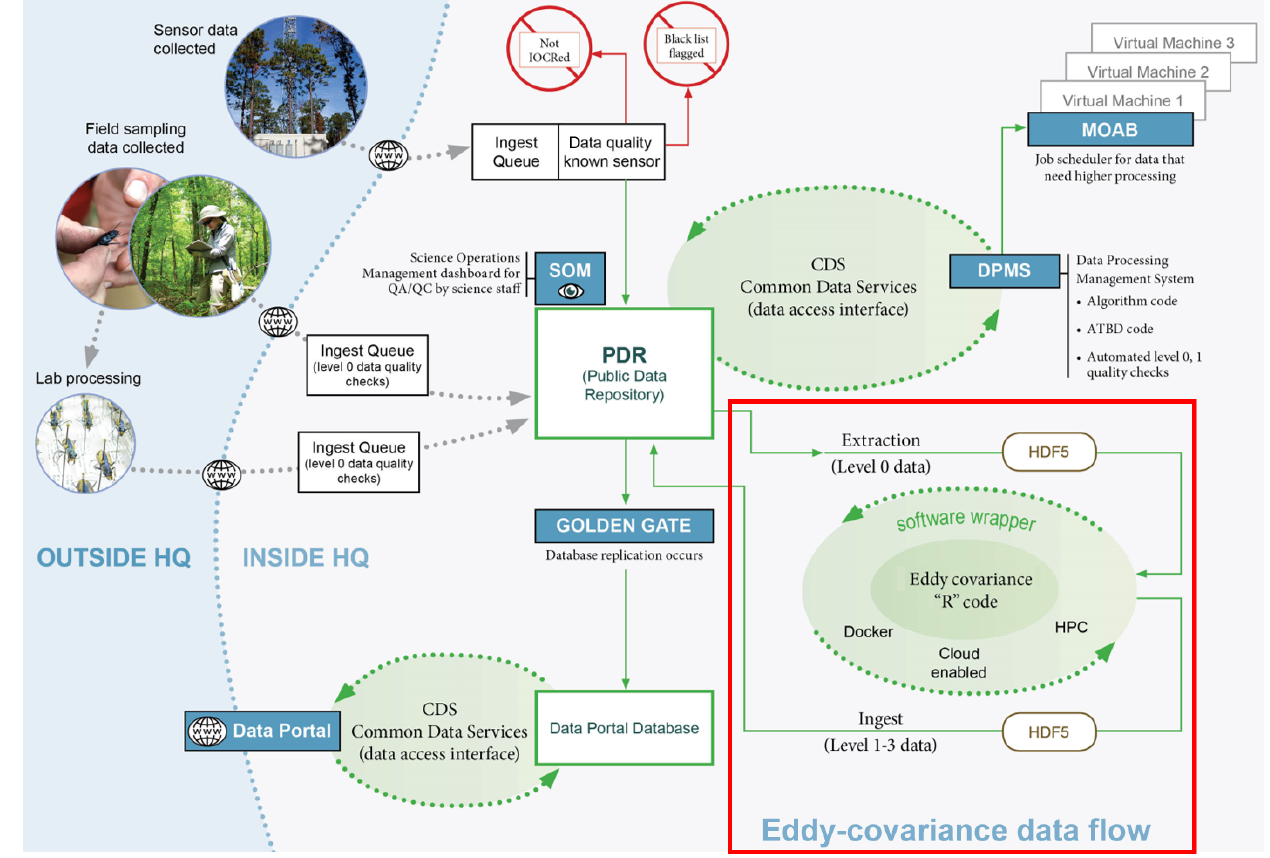
Figure 6. NEON’s CI for streaming data processing. The red box visualizes the eddy4R–Docker EC processing framework within the overall